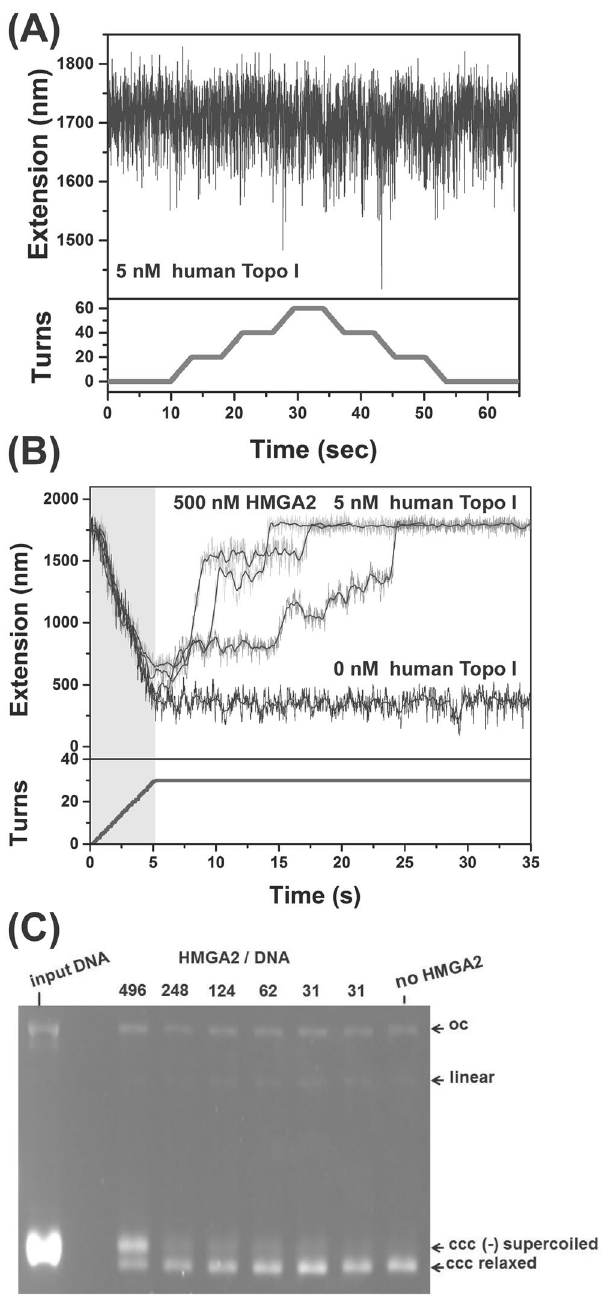
Figure 4. Effects of HMGA2 on supercoiling relaxation by human topoisomerase I. ( A ) A representative time-trace (top panel) of extension of a torsionally constrained DNA held at 0.3 pN during clockwise and anti- clockwise ration of the bead (bottom panel) in 5 nM topoisomerase I. The extension remains at the level of unconstrained DNA during bead rotations. ( B ) In the presence of 5 nM topoisomerase and 500 nM HMGA2, the bead rotation causes DNA supercoiling as indicated by extension decrease (gray time traces), which is slowly relaxed after the bead rotation was stopped. Data obtained in the same procedure in the absence of topoisomerase I and HMGA2 are shown for comparison (black time trace). ( C ) Analysis of covalently closed (ccc) relaxed and ( − ) supercoiled plasmid DNA after in vitro DNA relaxation reactions with human topoisomerase I. The two topological DNA forms were resolved via agarose gel electrophoresis in the presence of ethidium bromide. The stoichiometry of HMGA2 per DNA molecule in each reaction is indicated. Samples with the lowest amount of HMGA2 were run as duplicates. DNA in the left lane is 95% ( − ) supercoiled input plasmid DNA. See text for details and the full-length gel in Fig.